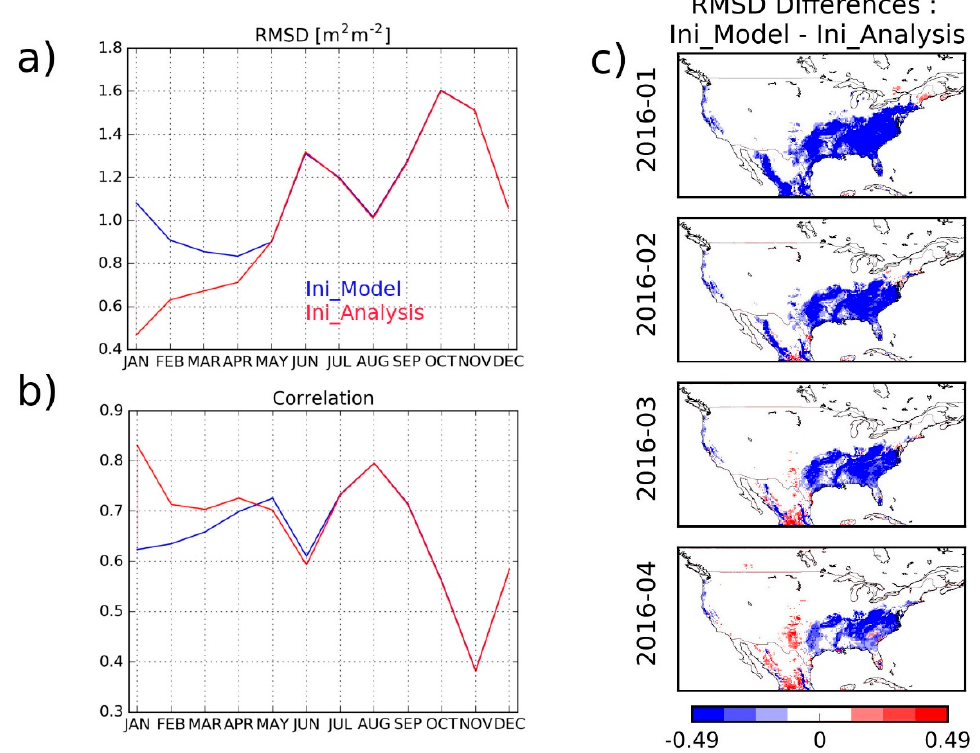
Figure 11. Seasonal ( a ) root mean square differences (RMSD) and ( b ) correlation values between observed leaf area index (LAI) and (in blue) a 12-month model run, (in red) a 12-month model run initialised by analysed conditions from LDAS-Monde. ( c ) RMSD differences values between a 12-month model run and a 12-month model run initialised by analysed conditions from LDAS-Monde.